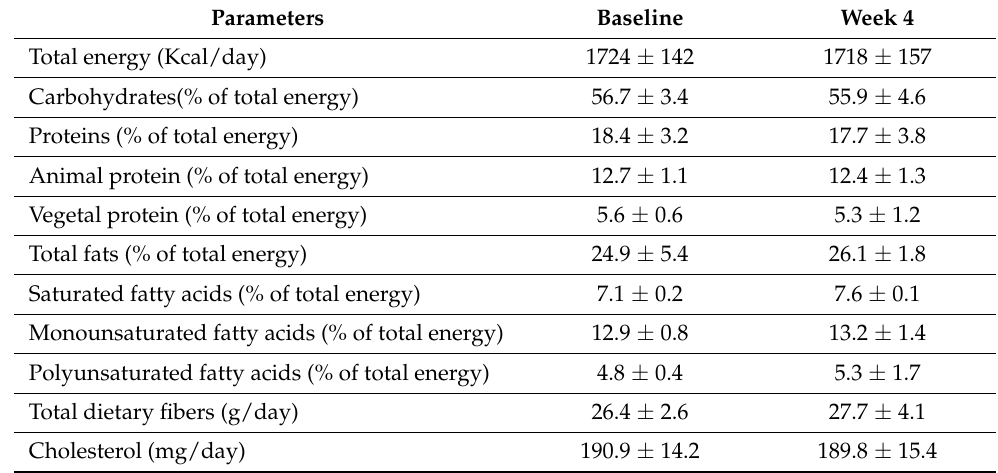
Table 3. Diet composition at enrollment and at the end of the study. Values are expressed as mean ±